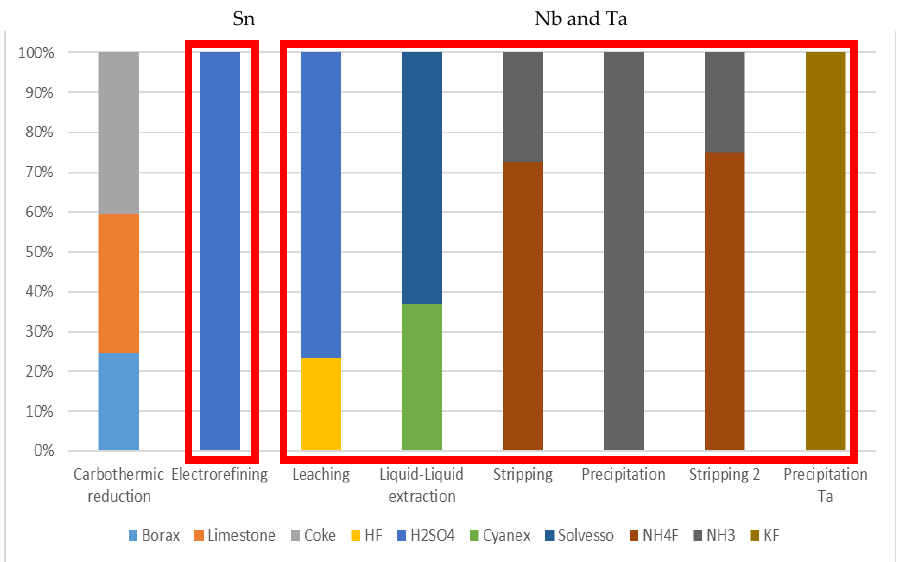
Figure 4. Share of reagents needed in each unit of the treatment and beneficiation process of Sn, Nb, and Ta.